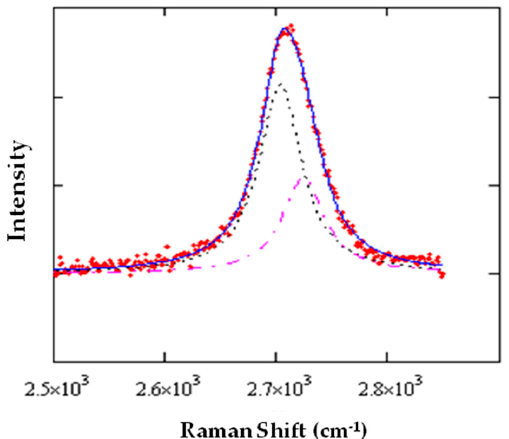
Figure 5. Typical 2D splitting of strained graphene grown on Co: the full line is the fit of the experimental points obtained by summing the two Lorentzian peaks (dotted and dash-dotted lines) representing the 2D − and 2D + components, respectively.